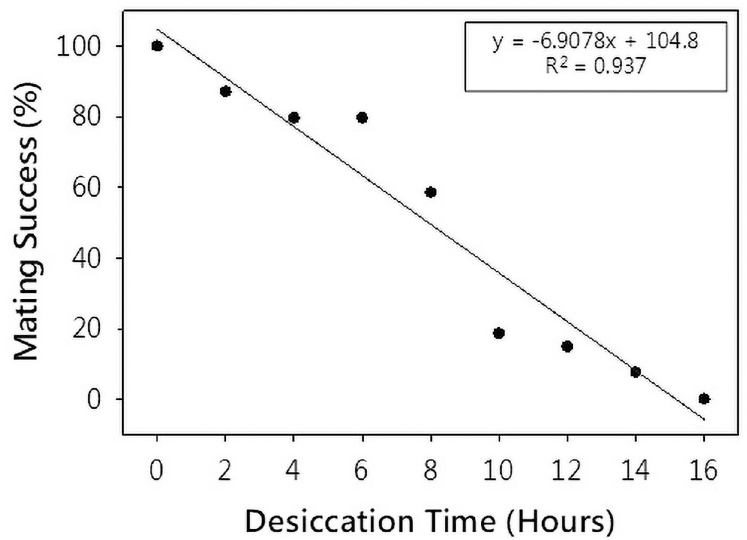
Fig 3. MT 50 value estimation. Scatter plot of mating success versus desiccation duration with inset: linear equation and R-squared value. The MT 50 value (desiccation time corresponding to 50% mating success) thus obtained was 7 hours and 39 minutes (Logit Regression). Each data point represents the average value recorded for a total of 54 pairs (9 pairs per replicate) and the error bars depict values of standard error. P-value obtained from ANOVA: Single Factor test: 1.4 � 10 − 20 .